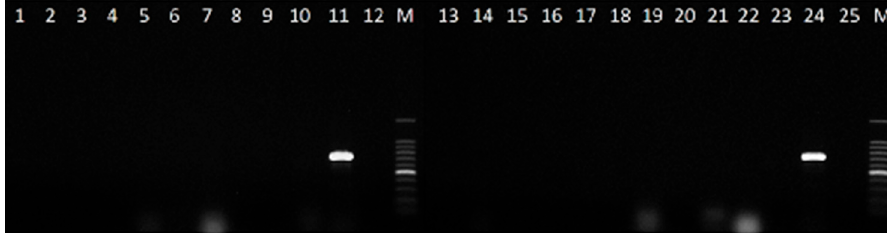
Figure 3. Specificity of PCR using the primer pair CLF / CLR for the detection of C. lupini . Lane 1 = Alternaria alternata , Lane 2 = Alternaria infectoria , Lane 3 = Alternaria tenuissima , Lane 4 = Arthrinium phaeospermum , Lane 5 = Aspergillus sp., Lane 6 = Botrytis cinerea , Lane 7 = Chaetomium sp., Lane 8 = Cladosporium oxysporum , Lane 9 – Curvularia hawaiiensis , Lane 10 = Diaporthe sp., Lane 11 and 24 = C. lupini IMI 504893, Lane 12 and 25 = negative control (without DNA), Lane 13 = Eurotium sp., Lane 14 = Fusarium incarnatum , Lane 15 = Fusarium tricinctum , Lane 16 = Lecytophora sp., Lane 17 = Mucor sp . , Lane 18 = Penicillium sp., Lane 19 = Pleospora sp., Lane 20 = Sordaria fimicola , Lane 21 = Trichoderma sp., Lane 22 = Meyerozima caribbica , Lane 23 = Sterile mycelium, and Lane M = 100 bp DNA ladder.